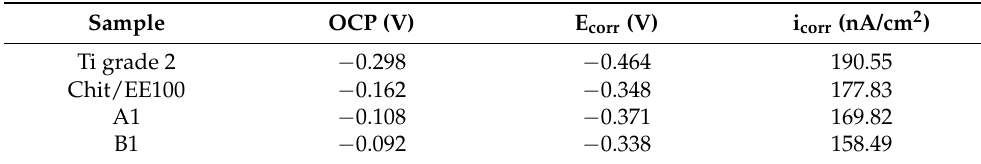
Table 5. OCP, E corr , and i corr values of the bare titanium substrate, chit/EE100 coating, and chit/EE100/AgNPs coatings (A1 and B1